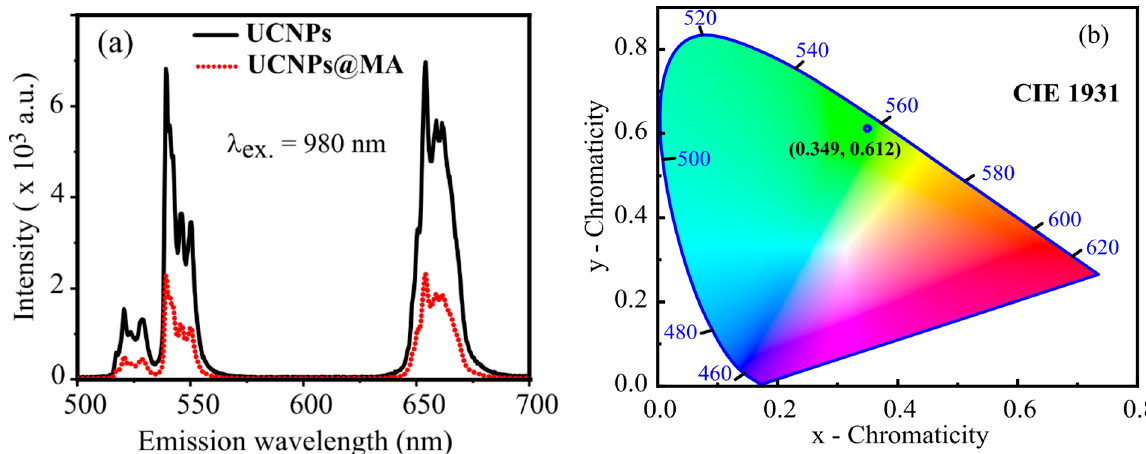
Figure 3. ( a ) UC photoluminescence spectra of UCNPs and UCNPs@MA obtained upon 980 nm excitation; ( b ) the CIE 1931 chromaticity coordinates of the UCNPs@MA.